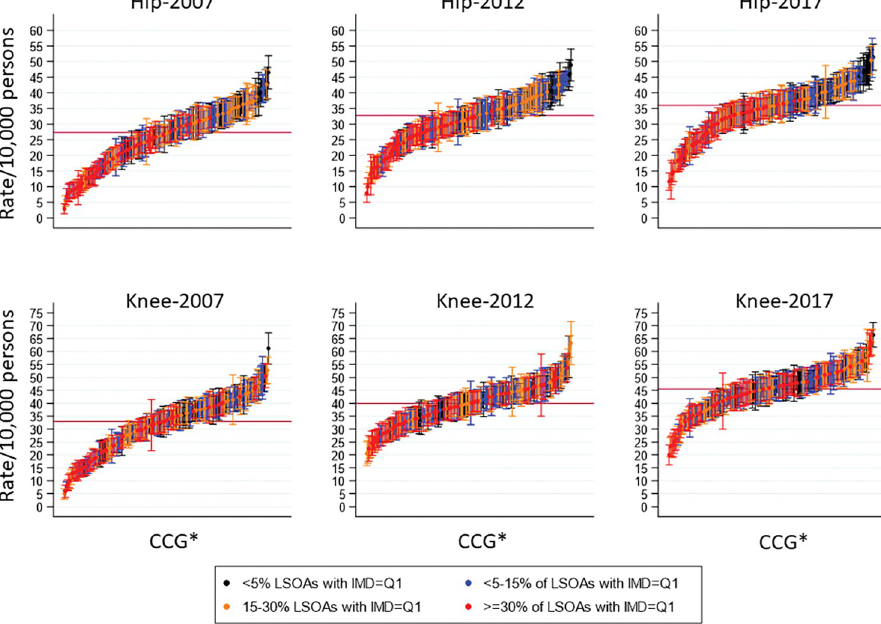
Fig 3. Rates with 95% confidence intervals of joint replacement provision per 10,000 persons for each CCG * , by concentration of deprived area of residence (LSOA with IMD = 1, most deprived). CCG, Clinical Commissioning Group; IMD, Index of Multiple Deprivation; LSOA, Lower Layer Super Output